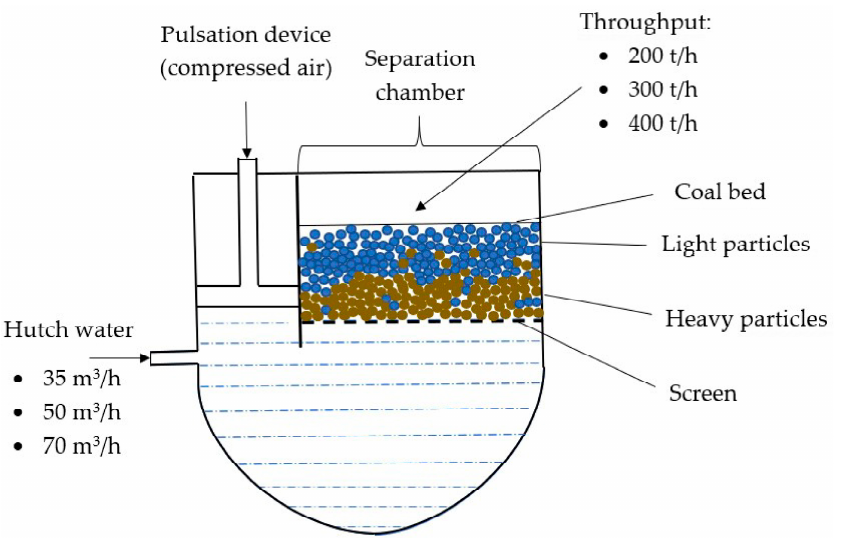
Figure 1. Scheme of a jig